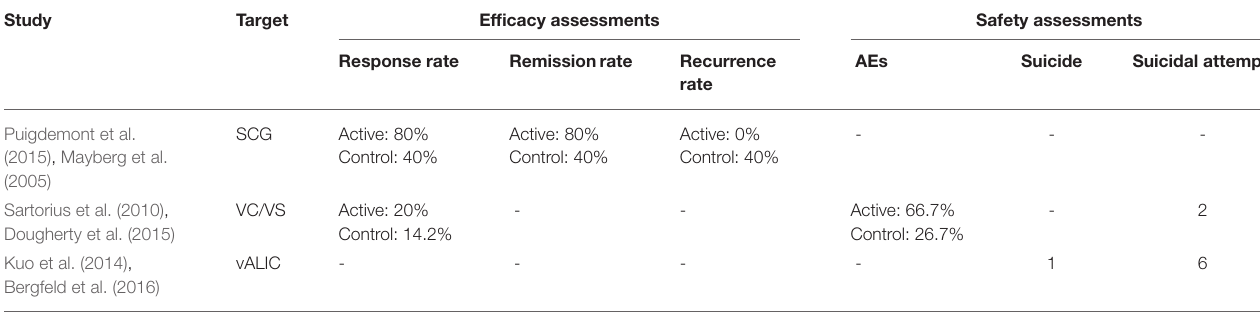
TABLE 3 | Summary of the efficacy and safety assessments (randomized controlled studies).